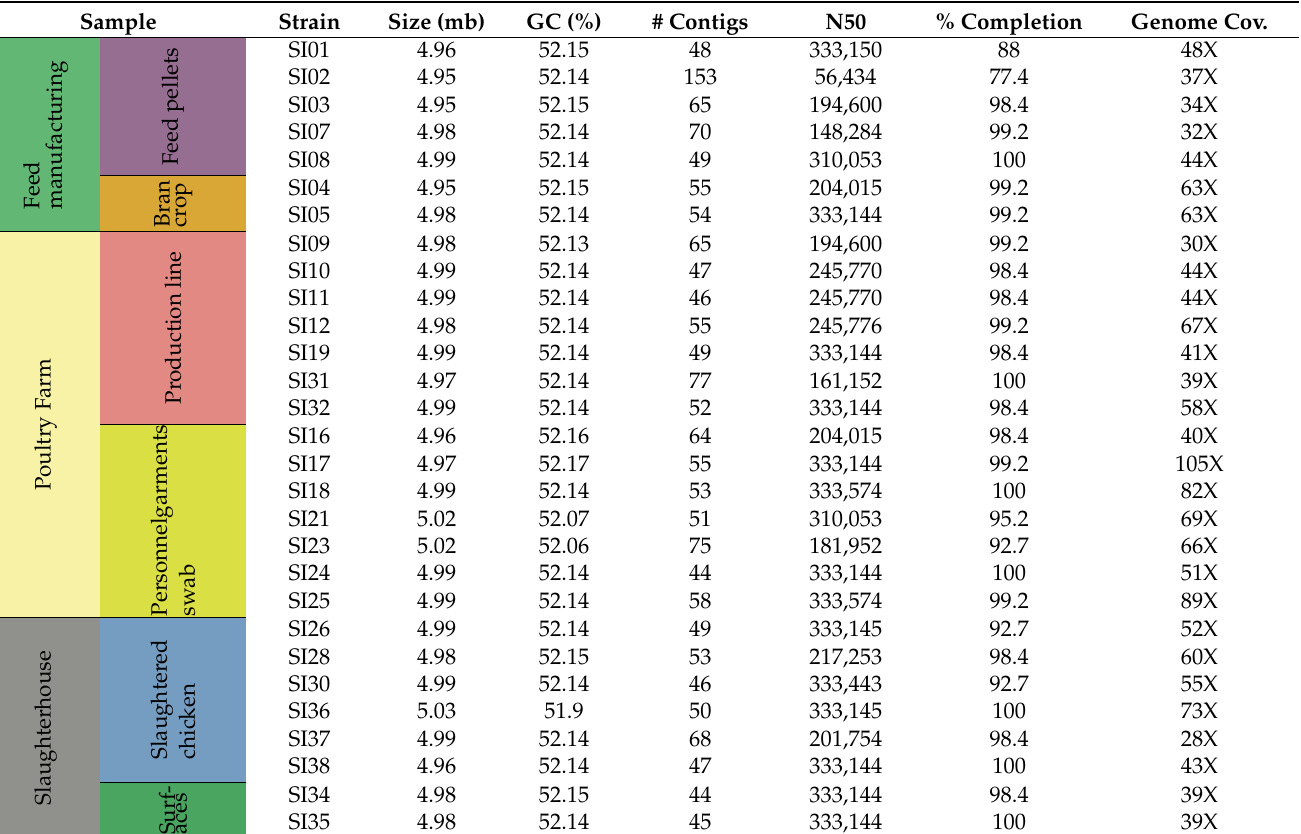
Table 2. Assembly statistics and evaluation for each of the 29 sequenced genomes of S. Infantis. Sample